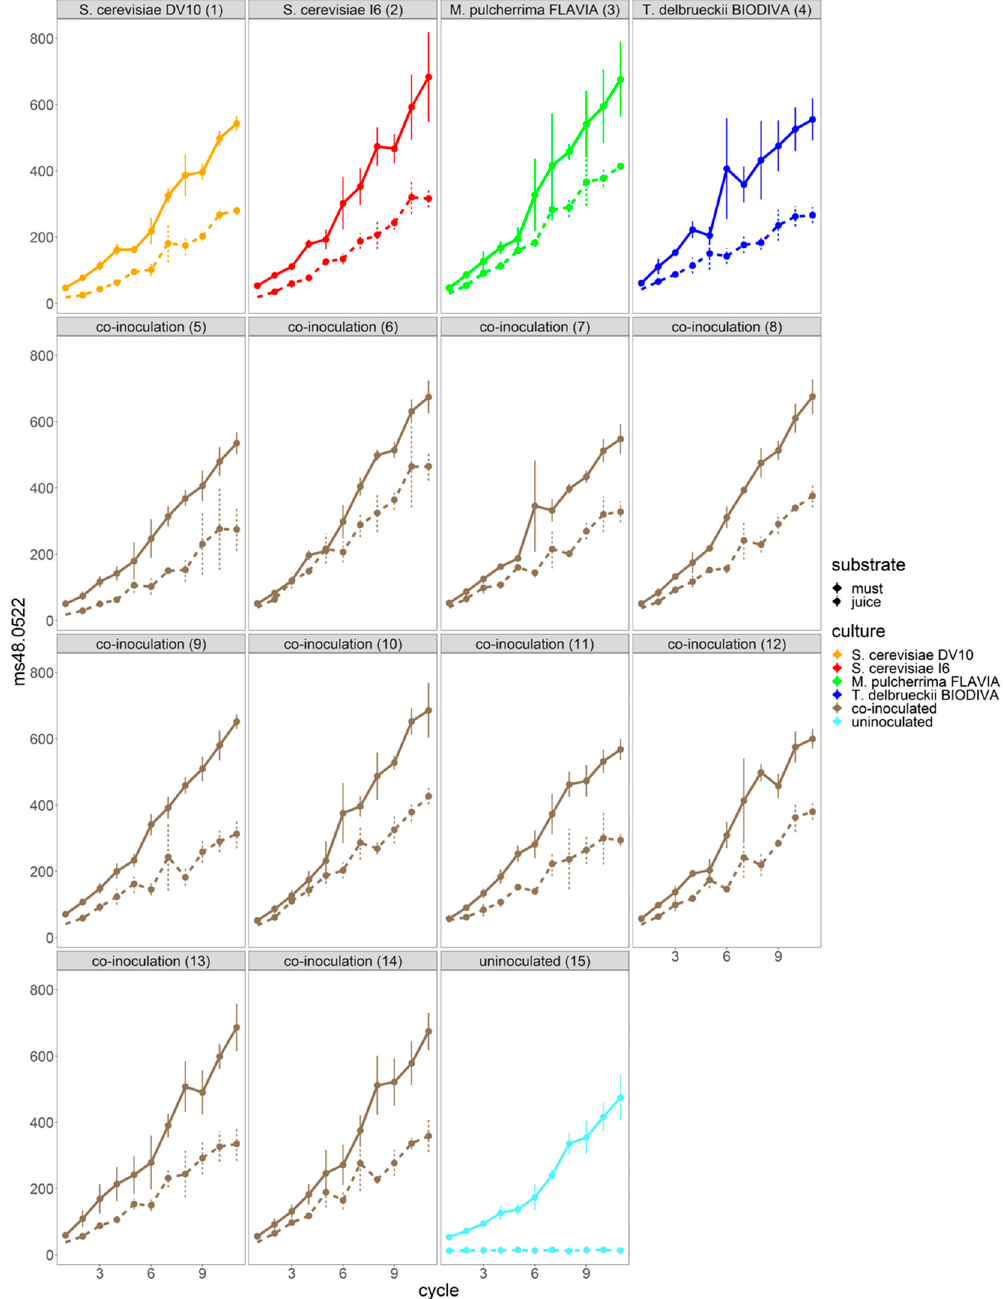
Figure 4. Score plot of principal component analysis of VOC emission evolution associated with the first three days of AF, separately represented for each trial (Table 1). Continuous lines indicate grape must and broken lines indicate grape juice. For a detailed view of the figure, the original image is included in the Supplementary Materials (Figure